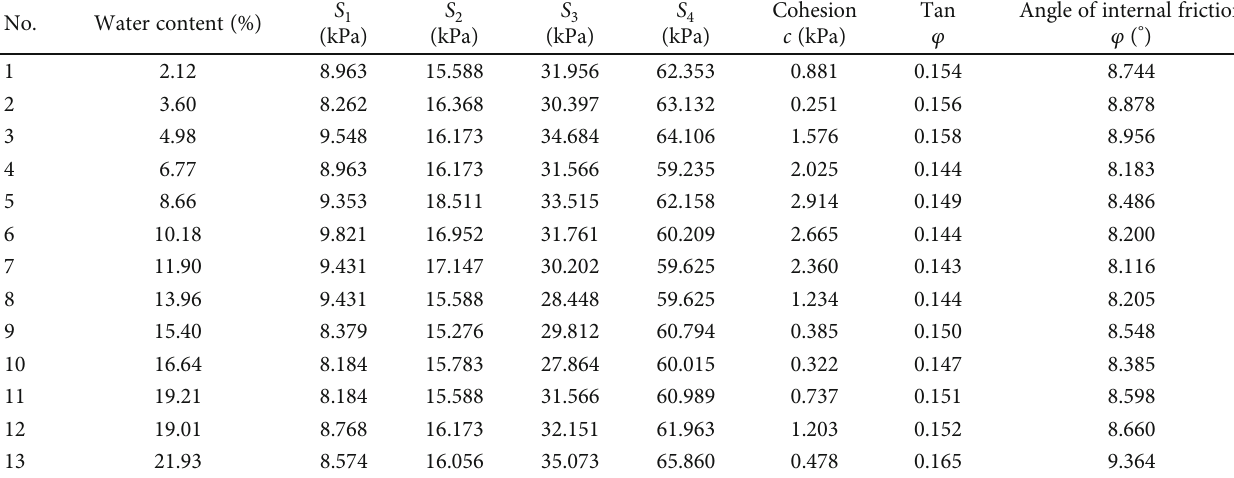
Table 2: Shear strength index under di ff erent water content